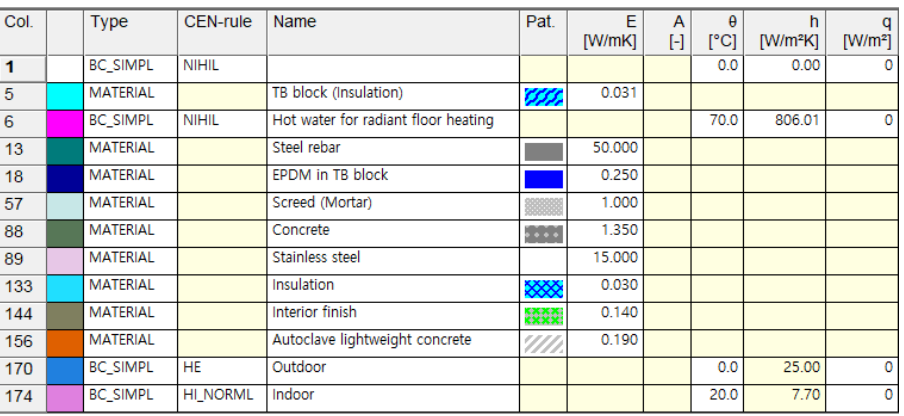
Figure 3. Material properties and boundary conditions in Physibel simulation.